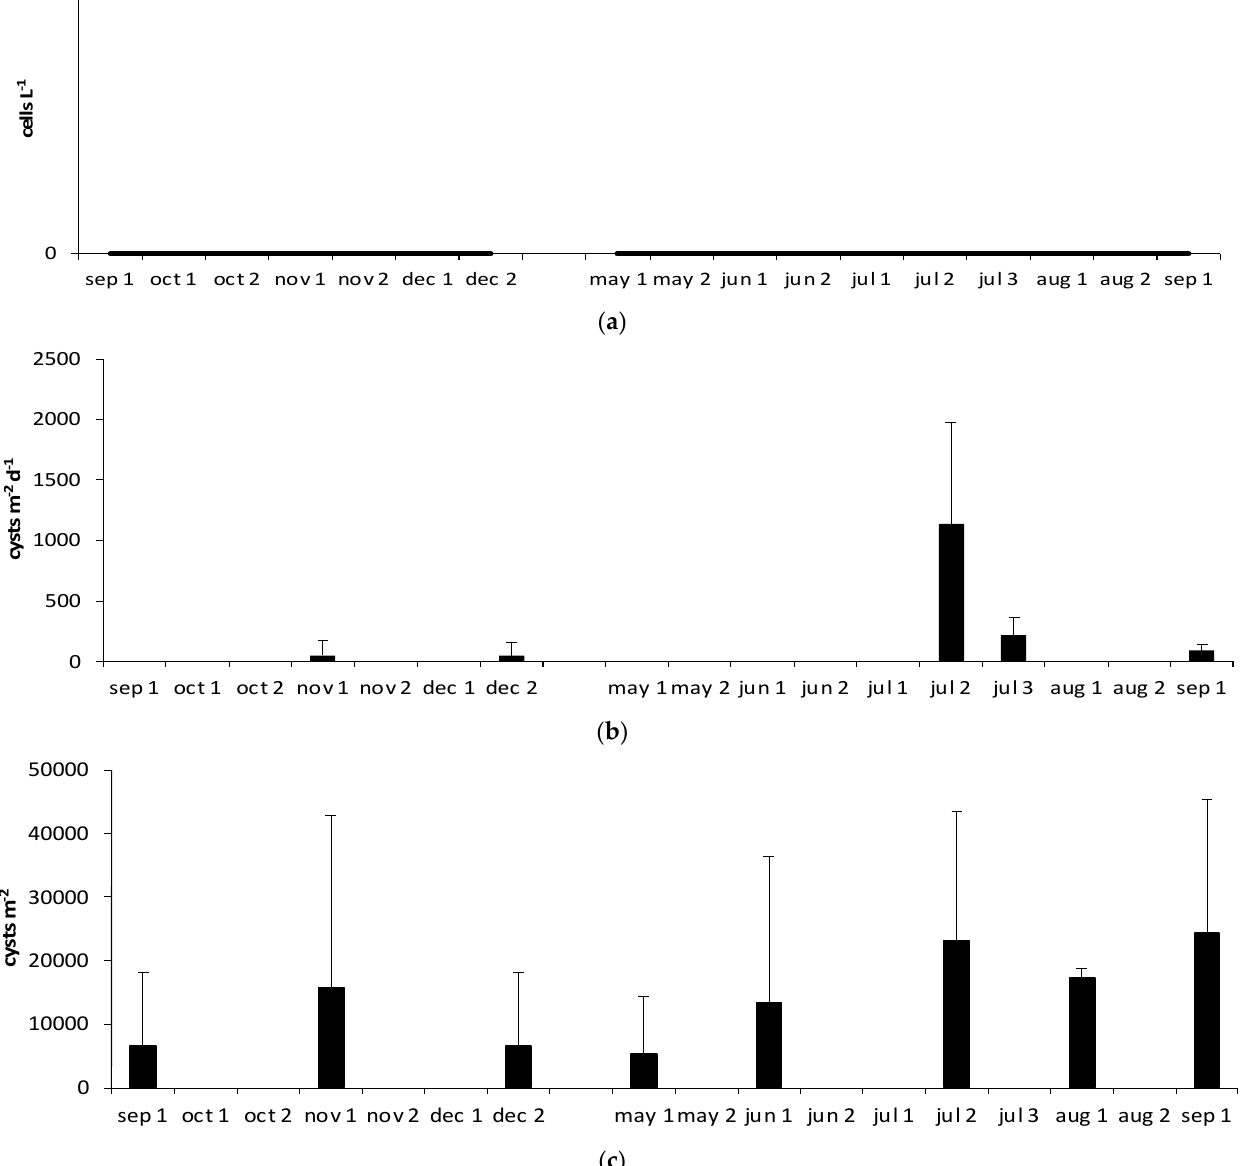
Figure 10. The pelagic-benthic dynamics of Follisdinellum splendidum in the Mar Piccolo of Taranto; ( a ) active cells in the water column; ( b ) cyst fluxes to the bottom, collected by sediment traps; ( c ) full cysts in the surface sediment cores.